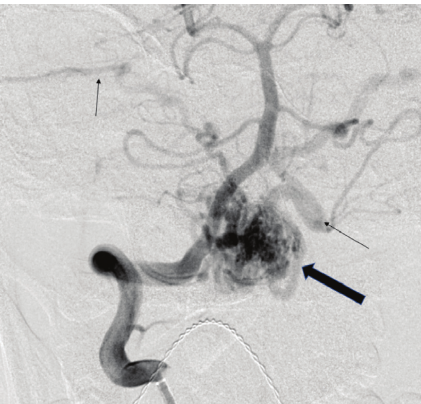
Figure 3: AP image from digital subtraction angiography. Right vertebral artery injection demonstrates filling of the nidus of ab- normal vessels in the posterior fossa (large arrow) fed by small branches of the right vertebral artery V4 segment. Early draining veins are evident (thin arrows) which drain to the transverse